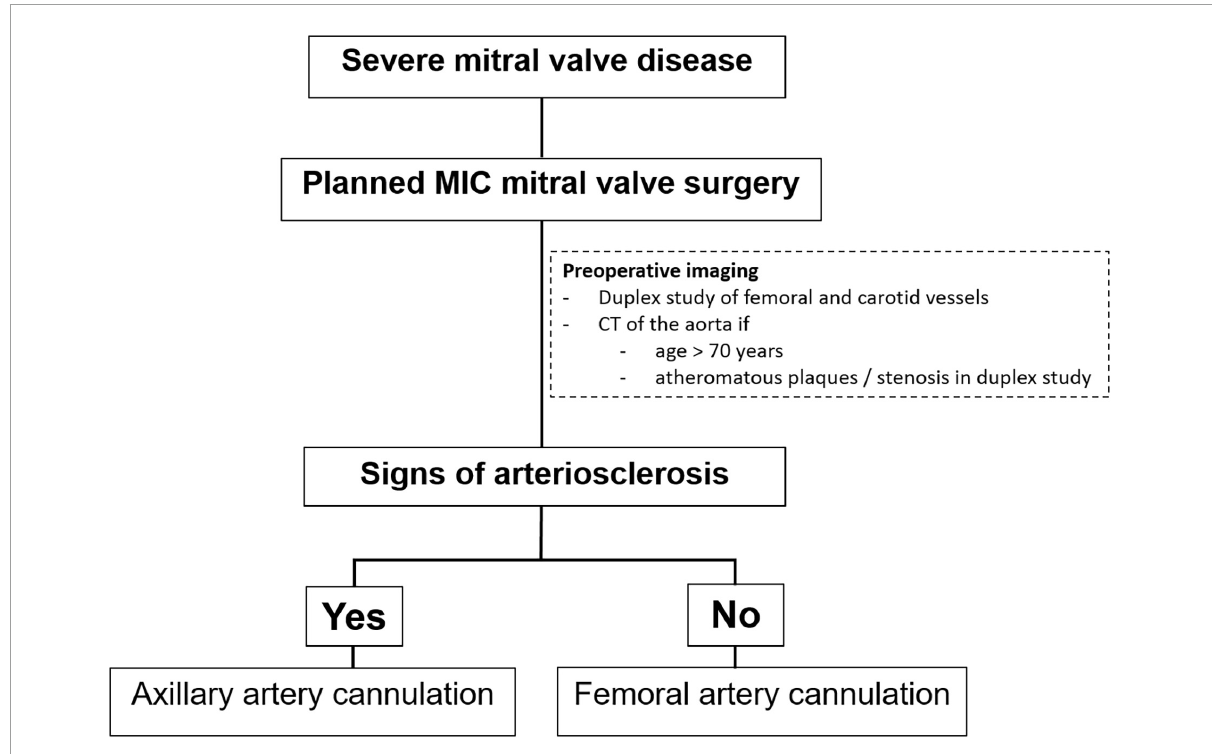
FIGURE1 Treatment strategy at our institution in patients with severe mitral valve (MV) disease planned for a minimally-invasive (MIC) mitral valve surgery.